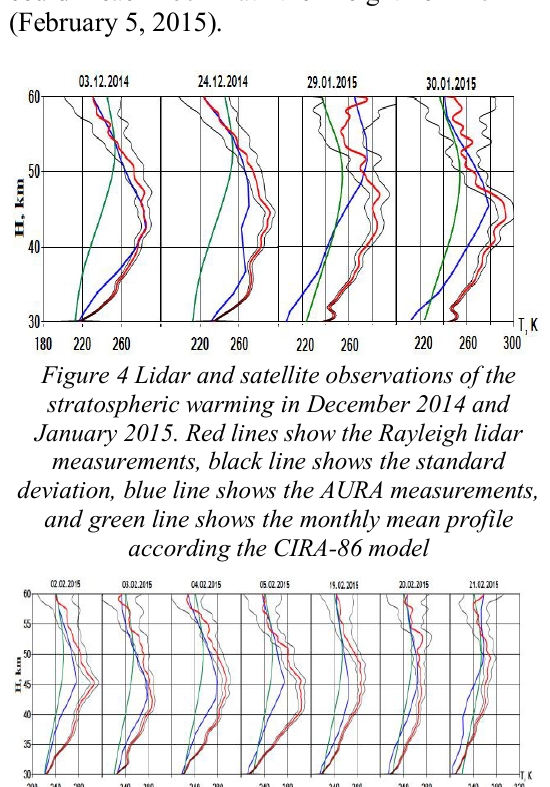
Figure 5 Vertical distribution of temperature in February 2015